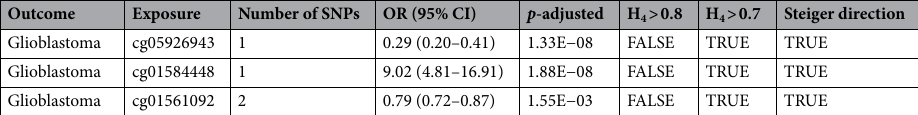
Table 3. CpG sites that met the FDR correction threshold < 0.05 in the MR analyses against glioblastoma, showed evidence of colocalization (H 4 > 0.7) and the correct direction of effect. OR odds ratio per standard deviation change in methylation, 95% CI 95% confidence intervals, p-value p-value for the observed effect, SNP single nucleotide